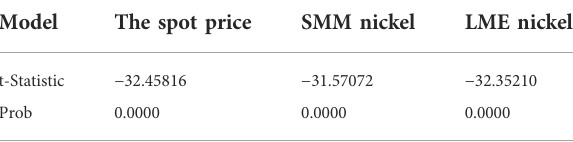
TABLE 2 ADF stationarity test results.